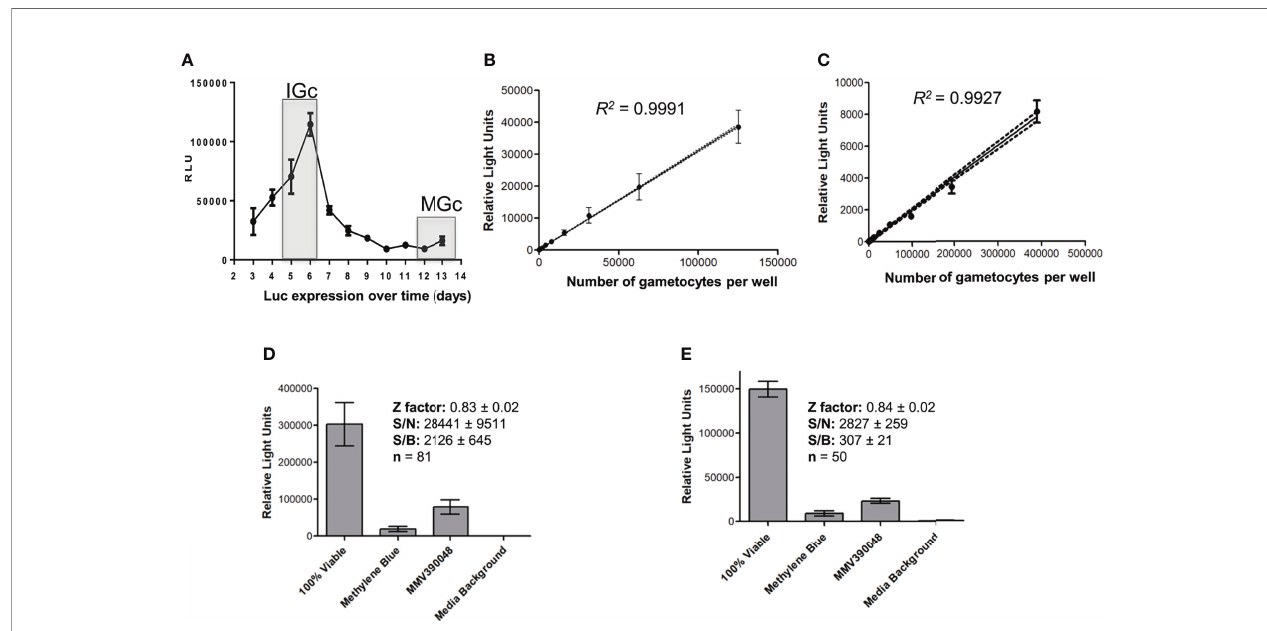
FIGURE 3 | Luciferase reporter assay metrics. (A) Assessment of luciferase expression (RLU) throughout gametocytogenesis for the transgenic line NF54- pfs16 - GFP-Luc on immature gametocytes (IGc, days 5 – 6), and the mature gametocytes (days 12 – 14, MGc). The linearity of luminescence readout compared to number of gametocytes per well for both the (B) immature and the (C) mature gametocytes. Data are from three independent biological experiments each performed in technical triplicates, ± SEM, 95% con fi dence intervals on each point indicated as ribbons. Assay metrics, including signal-to-noise (S/N), signal-to-background (S/B), and Z ′ -factor values for the luminescence readout (relative light units) on both the (D) immature and the (E) mature gametocyte assays, with 5 µM of either MMV390048 or